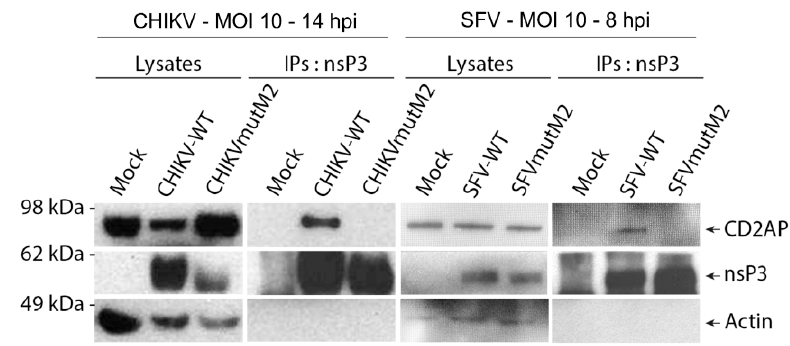
Figure 5. Interaction of CHIKV or SFV nsP3 with CD2AP in infected cells. HOS cells were infected with wt or mutant CHIKV or SFV at MOI of 10 and lysed at 14 (CHIKV) or 8 (SFV) hpi to carry out immunoprecipitation (IP) using antisera against nsP3 of CHIKV or SFV, respectively. Cell lysates and IP samples were probed for nsP3, CD2AP and actin.